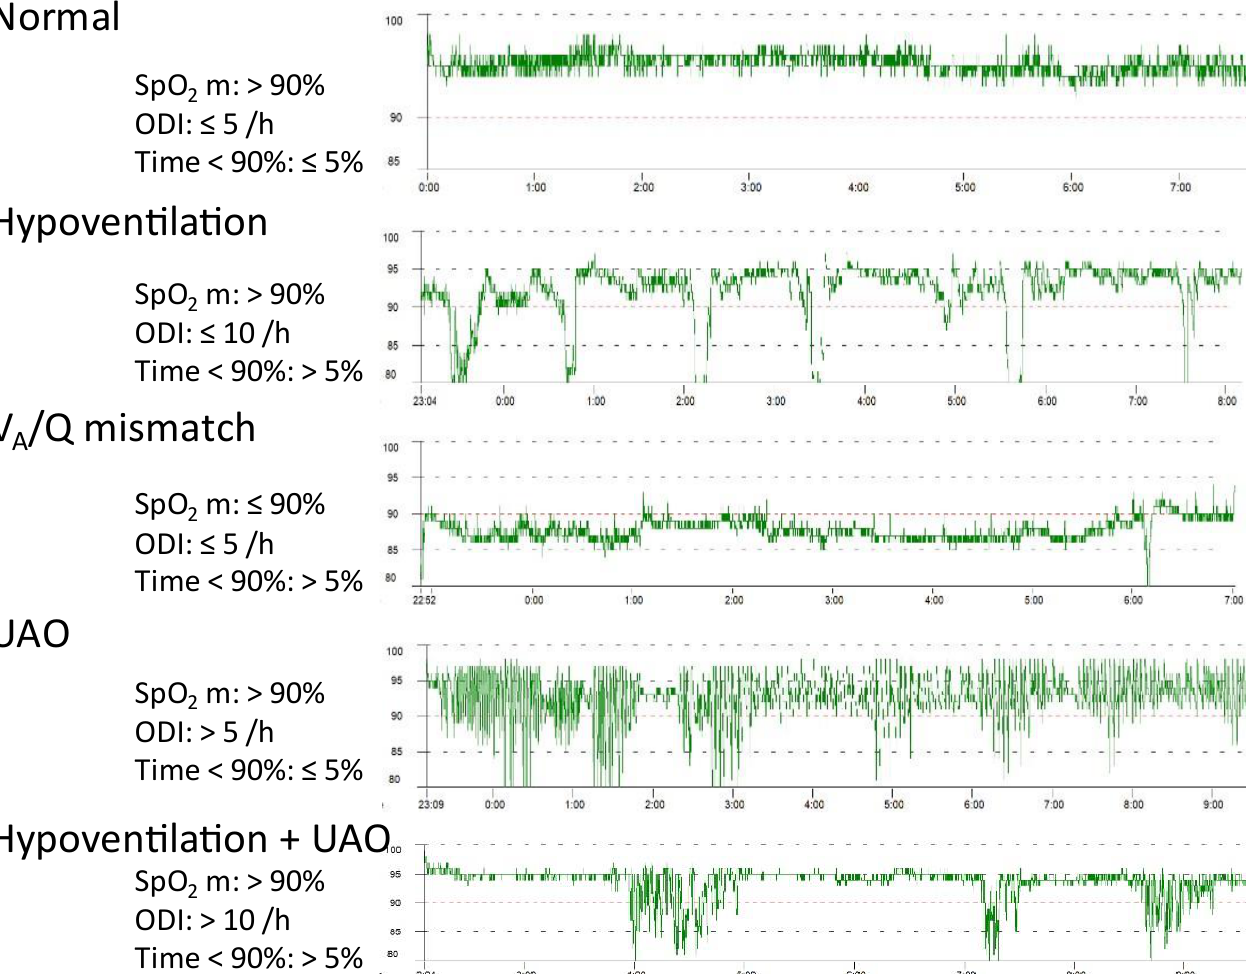
Figure 4. Nocturnal pulse oximetry measurement using a stand-alone device in patients using NIV. Typical results in statistics and on visual inspection of the SpO 2 curve for different types of respiratory events. Mechanisms of desaturation may coexist, which affect the SpO 2 curve. SpO 2 m: mean SpO 2 ; ODI: oxygen desaturation index; V A /Q: ventilation perfusion ratio; UAO: upper airway ob- structions.